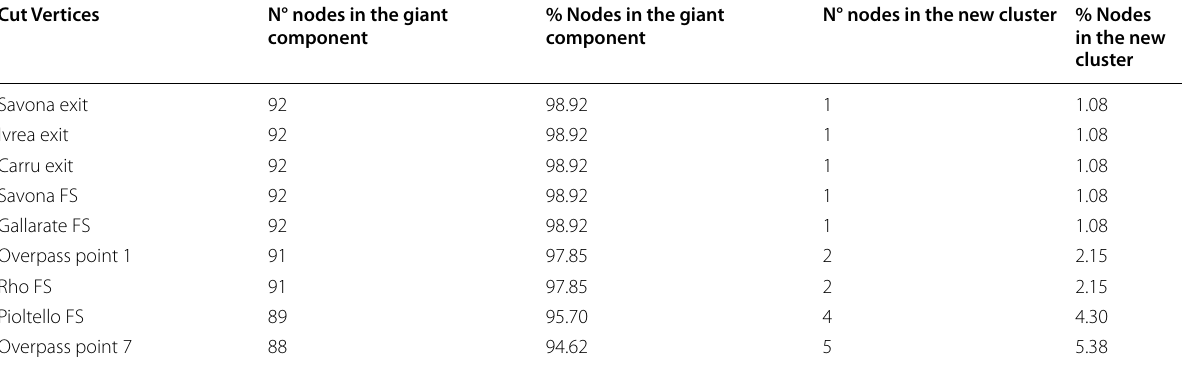
Table 1 Identification of Cut Vertices in the Multi-layer Network Cut Vertices N° nodes in the giant component